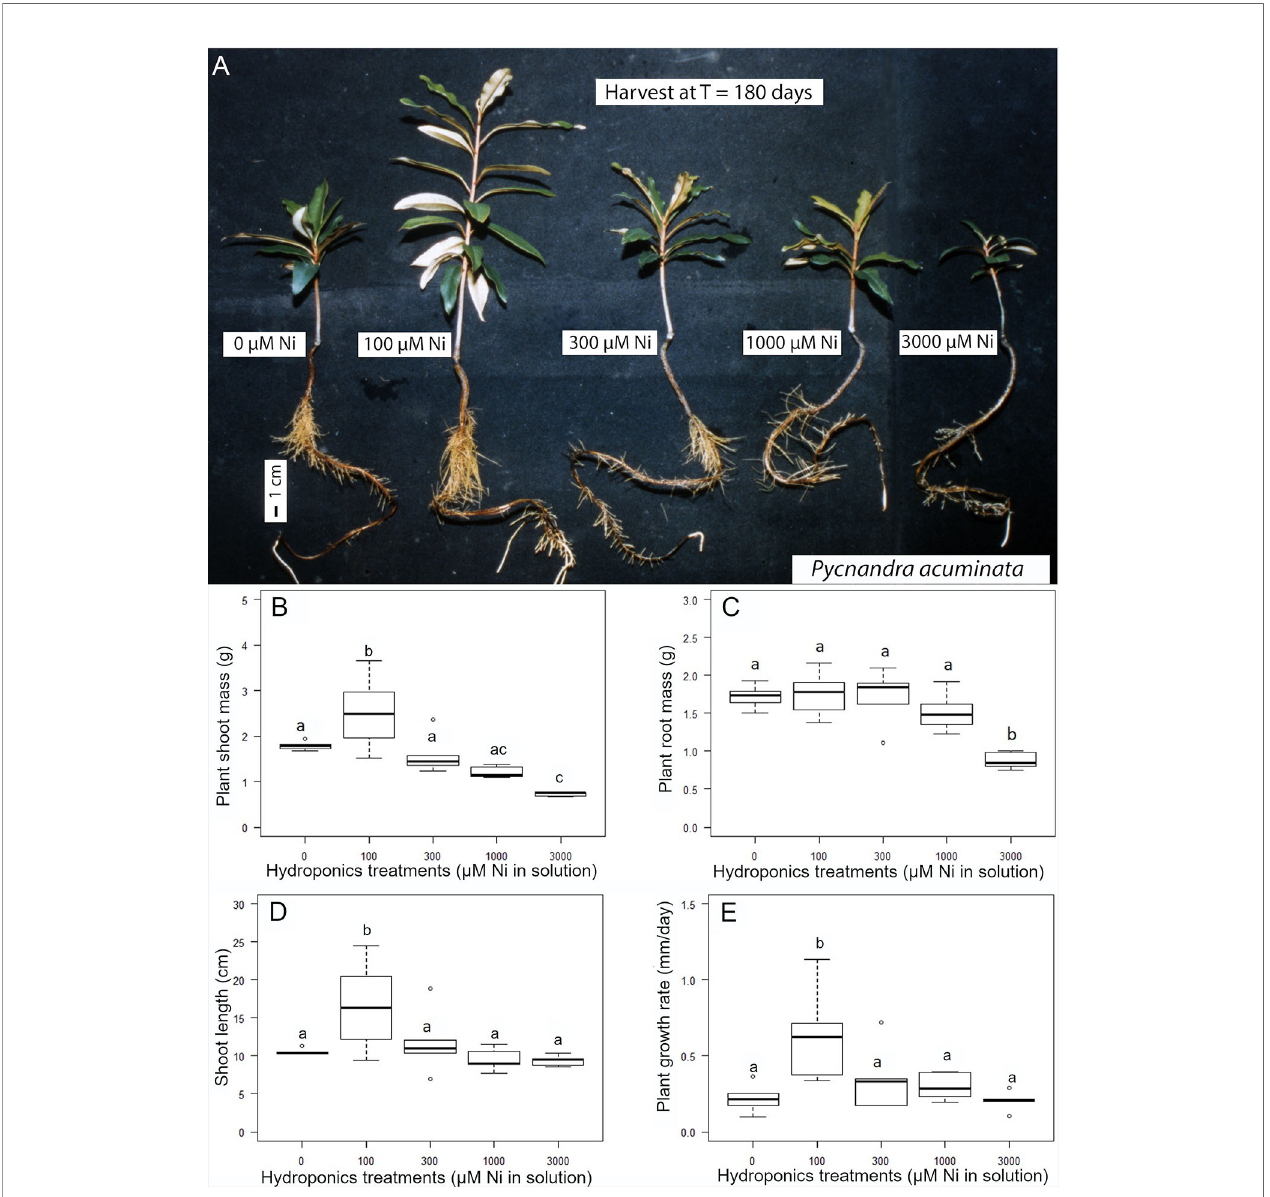
FIGURE 3 | Nickel tolerance of Pycnandra acuminata in hydroponic culture. (A) Plants exposed to the indicated concentration of Ni for 180 days. (B – E) Effect of nickel concentration in the nutrient solution on growth (n = 5). (B) Plant shoot biomass, (C) plant root mass, (D) plant shoot height and (E) plant mean relative growth rate. Letters indicate signi fi cant difference at 5% level (Waller-Duncan k-ratio t-test). TABLE 2 | Bulk elemental concentrations (ICP-AES) of macronutrients in PreC-Shoots, PstC-Shoots, and roots of 180 days Pycnandra acuminata plants as a function of the Ni concentration in the nutrient solution. Treatment (µmol L − 1 Ni) Tissue macronutrient concentrations PreC-Shoots PstC-Shoots